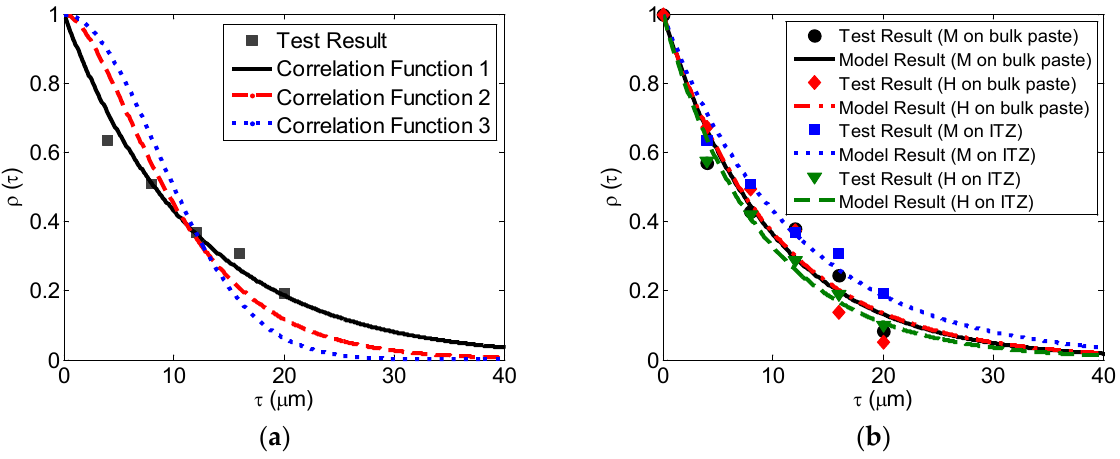
Figure 9. Model results and test results of correlation structure: ( a ) for nanoindentation modulus of ITZ; ( b ) for nanoindentation properties of the ITZ and the bulk paste. Table 5. The values of the squared 2-norm of the residual.